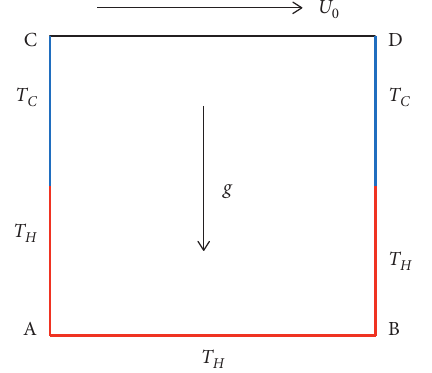
Figure 1: Differentially heated lid-driven square cavity.